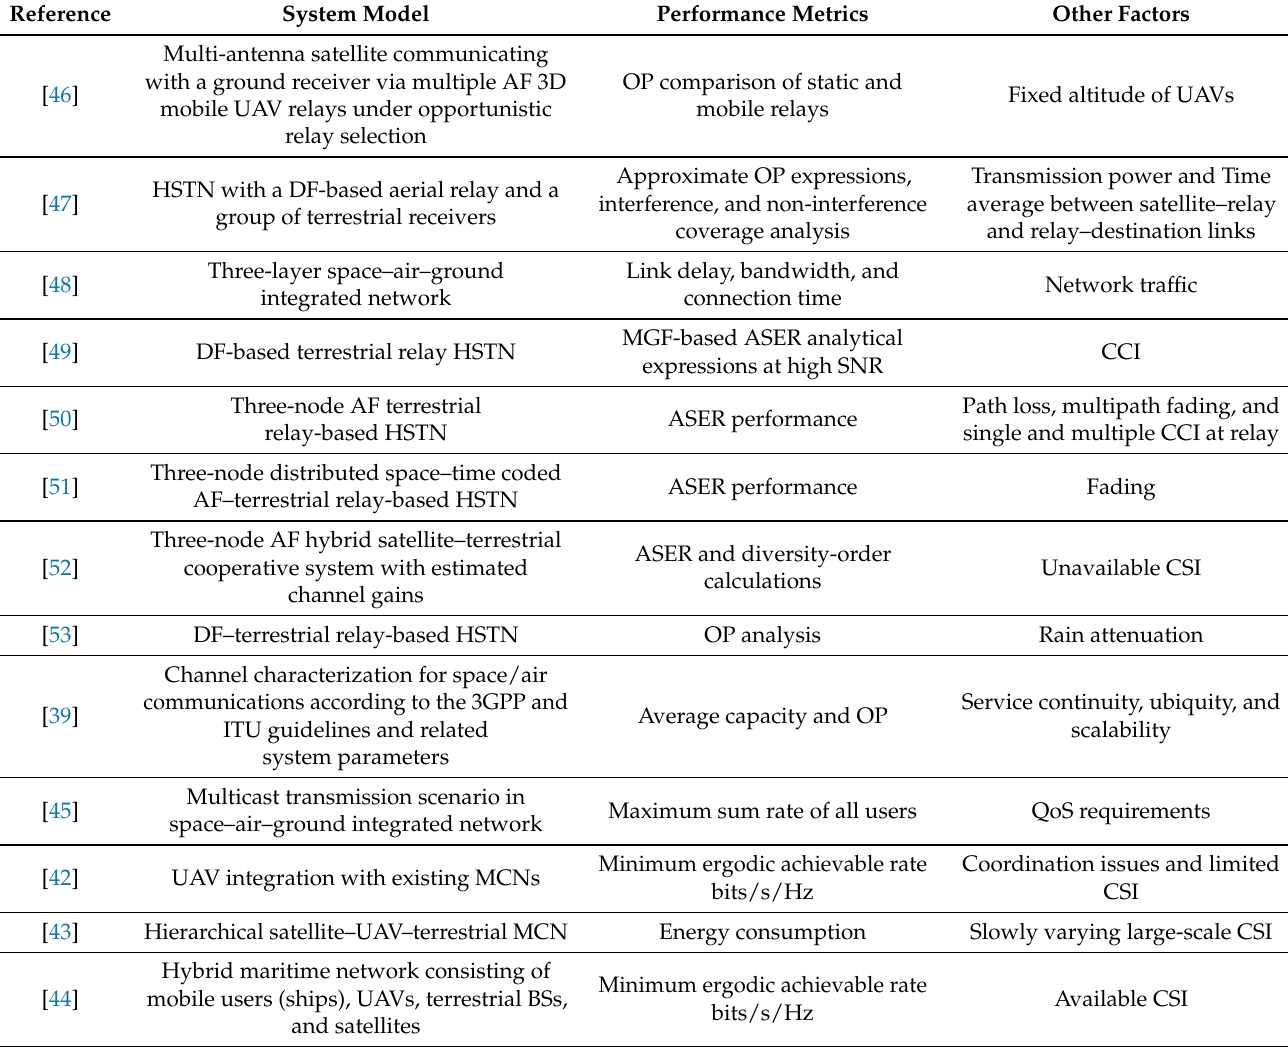
Table 3. List of major contributions to coordinated HSTN